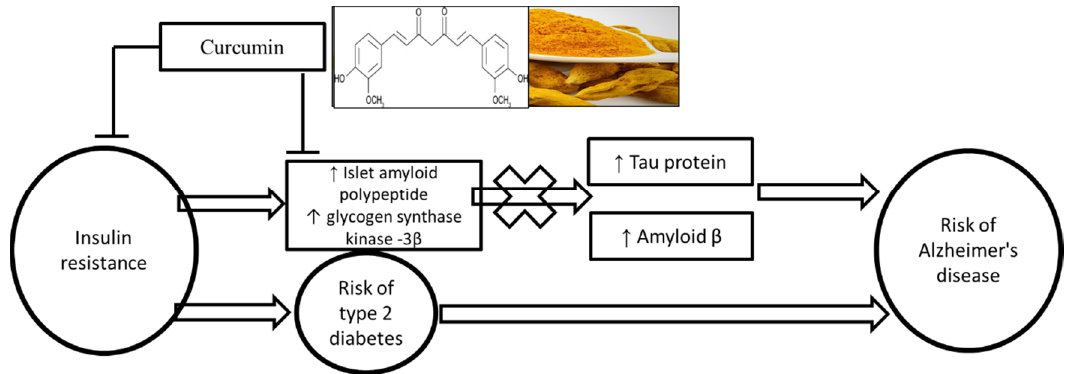
Figure 4. Summary of potential mechanism of curcumin in reducing the risk of type 2 diabetes and Alzheimer’s disease.